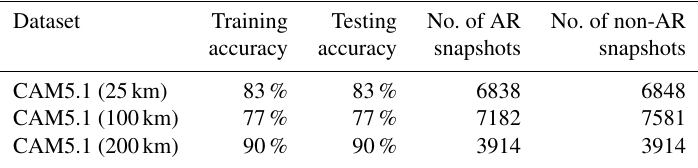
Table 3. Classification accuracy score estimated by the SVM classifier for 3-hourly temporal resolution of the CAM5.1 model with three different spatial resolutions. The table also shows the number of snapshots (number of events for both categories: ARs and non-ARs).